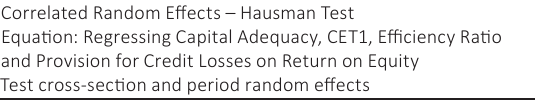
Table 1. Results of the Hausman test for